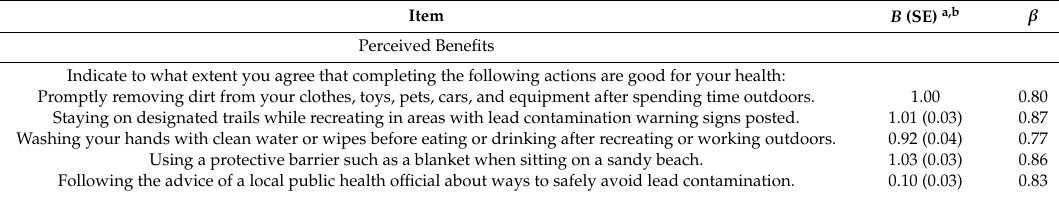
Table 3. Confirmatory factor analysis of the Health Belief Model (HBM) and behavioral intentions variables ( n =